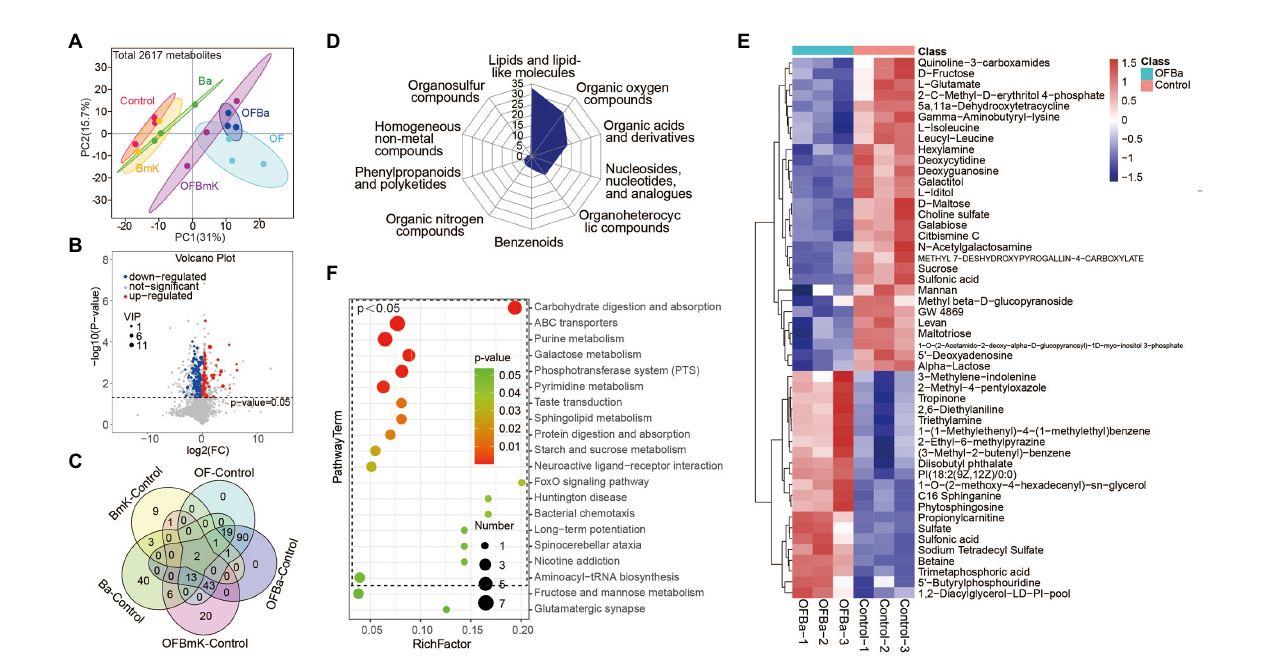
FIGURE 6 Analysis of soil metabolites in the OFBa fertilization group. (A) Principal component analysis of soil metabolites in the different fertilization treatment groups. (B) Volcano plot of soil microbial metabolites in the OFBa treatment group. (C) Intersections of differential metabolites (DEMs) between fertilization and control groups. Classification of soil DEMs in the OFBa treatment group (D) and DEM content change analysis (top 50) (E) . (F) Enrichment analysis of DEM- associated metabolism pathways (top 20) in the OFBa treatment